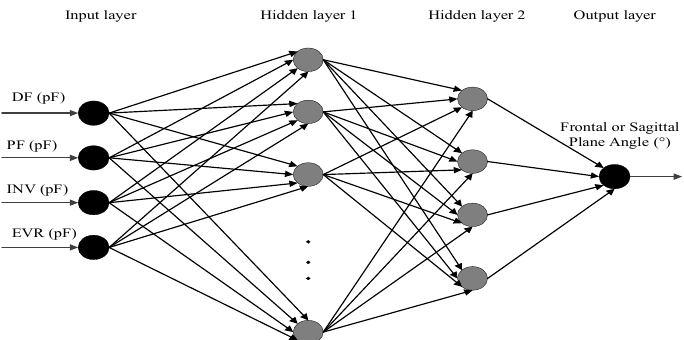
Figure 2. A general artificial neural network (ANN) structure with two hidden layers. (DF = dorsiflexion, PF = plantar flexion, IN = inversion, EVR = eversion).